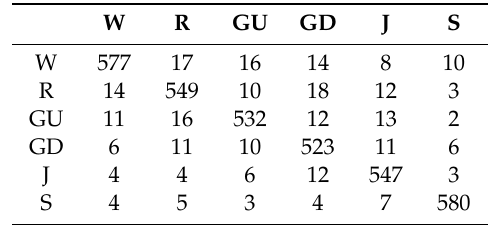
Table 8. Confusion matrix for DMGSOSEN-based HAR on the data from the right arm when the initial pool size is 100.